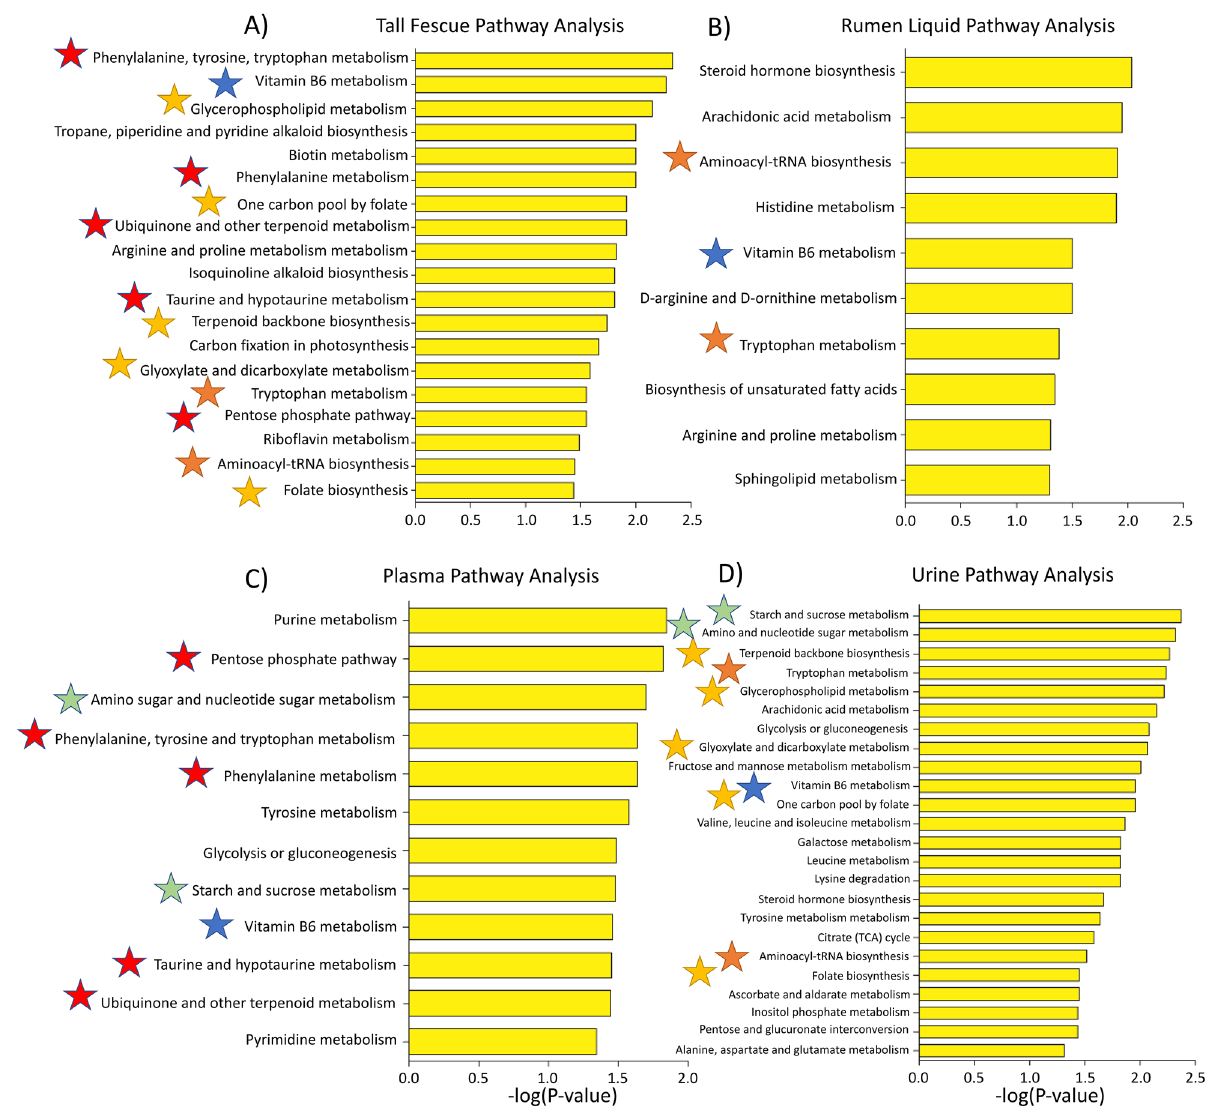
Figure 2. Metabolic pathway analysis performed on the ( A ) tall fescue plant, ( B ) rumen, ( C ) plasma and ( D ) urine high-resolution metabolomics features using mummichog. Putative metabolic pathways significantly ( P < 0.05) affected by toxic tall fescue (E+) in the plant and animal throughout the 28-day grazing trial are presented. The negative log of the FDR- corrected P value for each metabolic pathway indicated on the y-axis is on the x-axis. Blue star signifies overlapping pathways between all biological matrices; orange is fescue grass, rumen liquid, and urine overlap; red is fescue grass and plasma overlap; yellow is fescue grass and urine